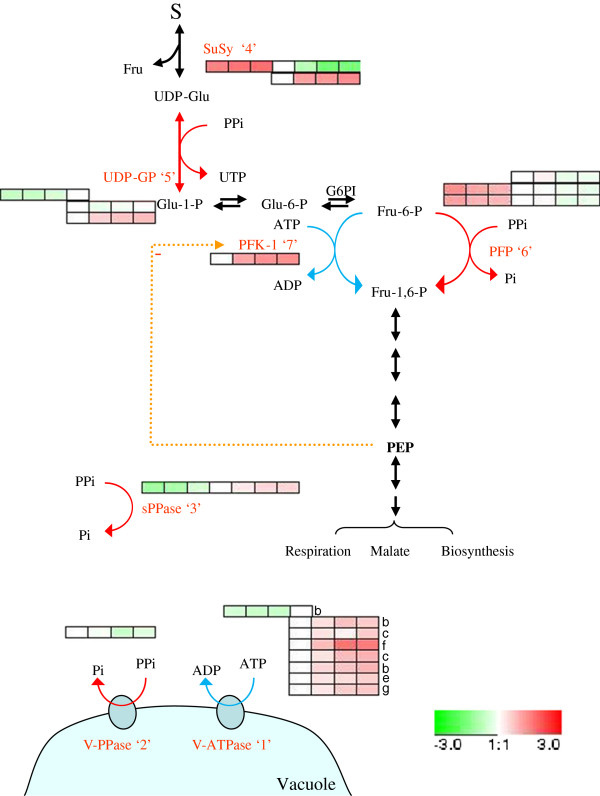
Scheme of the pyrophosphate (PPi) metabolism. The PPi-dependent (red line) and ATP-dependent (blue line) reactions are highlighted. The protein levels of the regulated enzymes are shown in coloured squares, indicating the change of expression (log2 ratio) for each developmental stage in relation to the 15 mm stage. In sequence order (left to right), stages are displayed from FS, 4 mm, 7 mm, 15 mm, V-100, 110 g/l, and 140 g/l. Different proteins isoforms or subunits are shown as different rows. SuSy, sucrose synthase; UDP-GP, UDP-glucose pyrophosphorylase; PFK-1, phosphofructokinase 1; PFP, pyrophosphate-dependent phosphofructokinase; sPPase, soluble pyrophosphatase; V-ATPase, vacuolar ATPase; PP-ase, vacuolar pyrophosphatase.